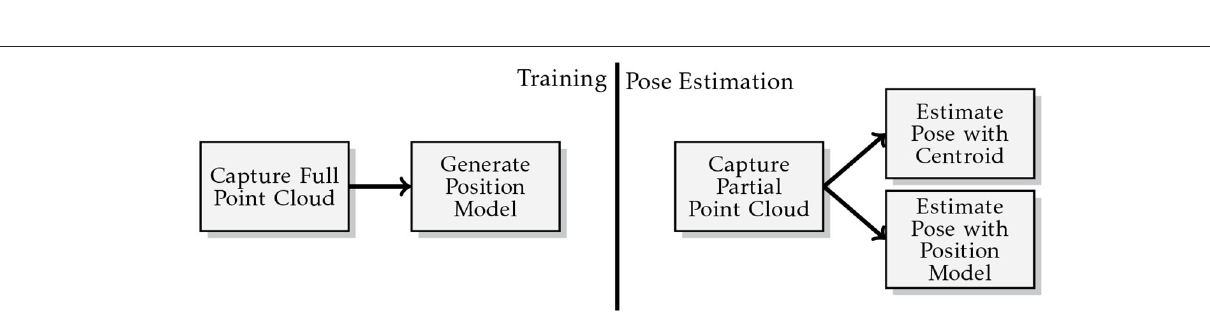
FIGURE 8 | Illustration of the methodology used for the pose estimation